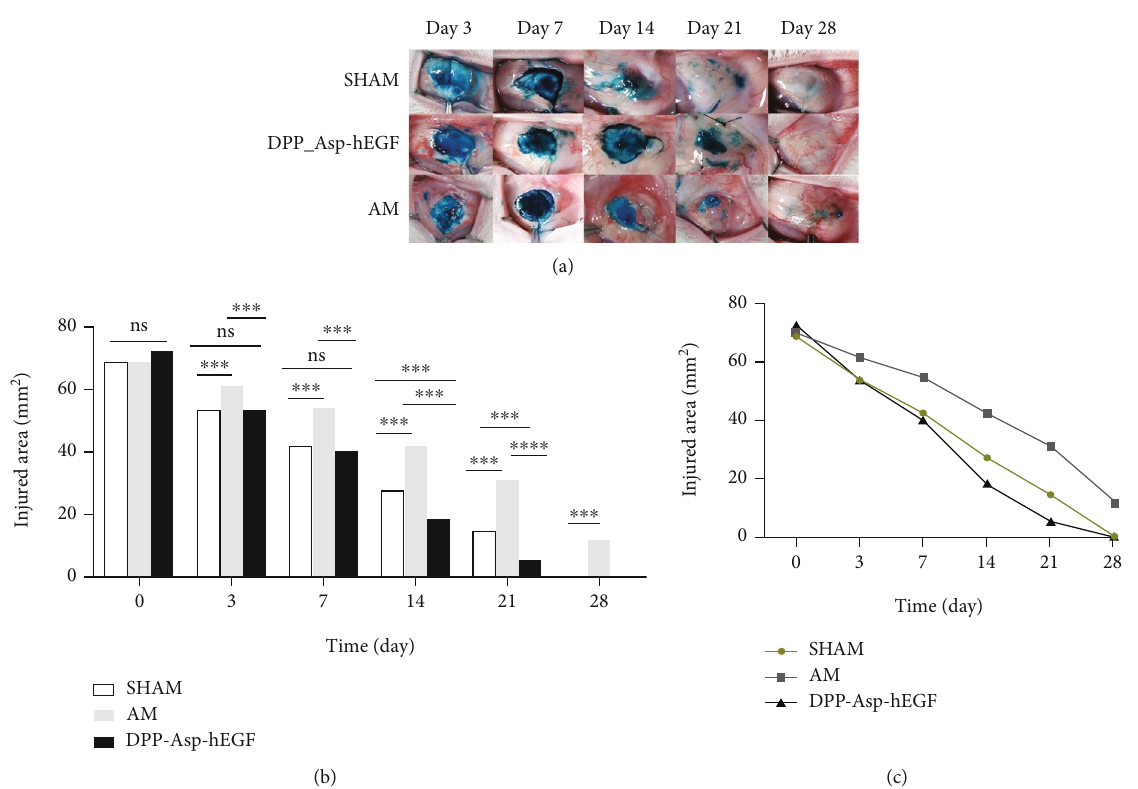
Figure 6: Reepithelialization in rabbit conjunctival defect model. The epithelial defects were stained with lissamine staining in each group at the various time points (a). (b) Histogram and (c) line graph showing residual epithelial defect area during process of repair, respectively ( ∗∗∗ p < 0 : 005 , ∗∗∗∗ p < 0 : 001 ; ns=nonsigni fi